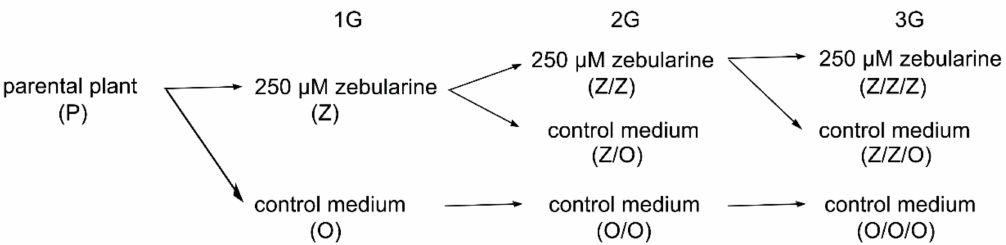
Figure 1. Experimental design. Seeds of A. thaliana of Columbia-0 (Col), Landsberg erecta (Ler), and Wassilevskija (Ws) ecotypes were germinated for 7 days on a control medium (O) or a medium supplemented with 250 µ M zebularine (Z), and plants were cultivated in soil without the drug (first generation, 1G). Seeds from one parental plant (P) were germinated to limit the contribution of inter-individual variability in telomere lengths. Seeds from selected 1G plants were germinated either on a medium supplemented with zebularine (Z/Z) or on a control medium (Z/O and O/O), and plants were grown in the soil (second generation, 2G). The same protocol was followed once more to get the third generation (Z/Z/Z, Z/Z/O, and O/O/O, 3G) plants. This nomenclature is used in the following text and